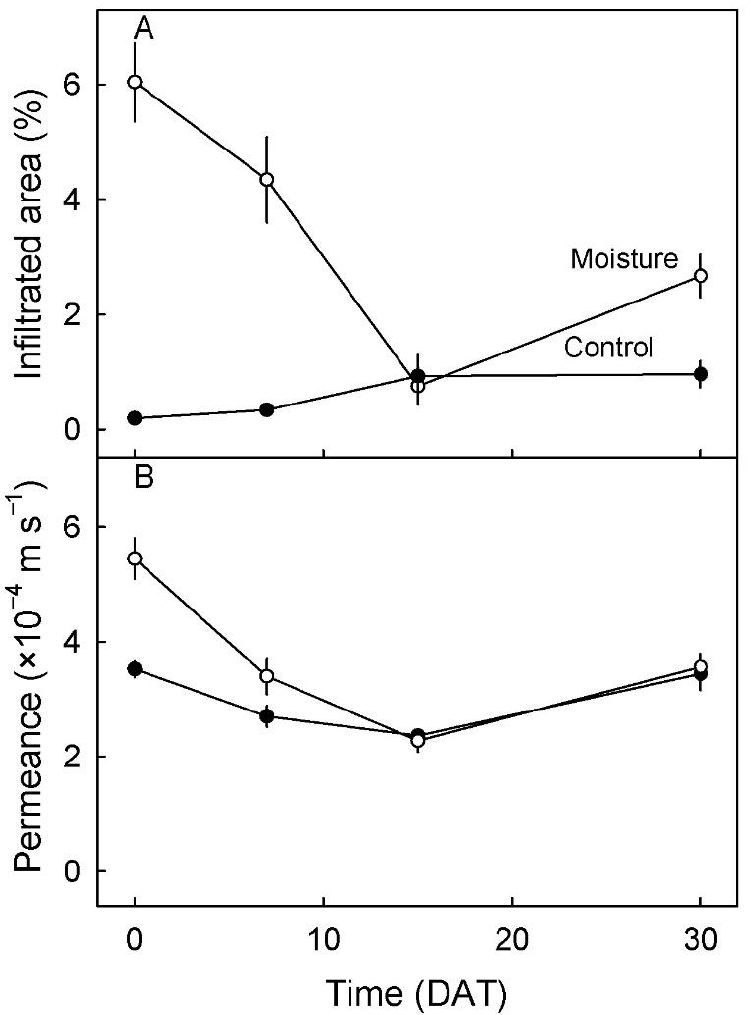
Figure 4. Time course of changes in microcracking ( A ) and permeance to water vapor ( B ) of fruit skin of mango cv. apple after 8 days exposure to moisture. X-axis scale in days after treatment (DAT). At 72 days after full bloom, the cheek of the developing fruit was exposed to moisture for 8 d. Thereafter, the time course of change in microcracking and permeance after moisture termination was followed. Unexposed fruit surfaces served as controls. N = 40 (microcracking) and 12 (permeance). Data represent the means ± SE.